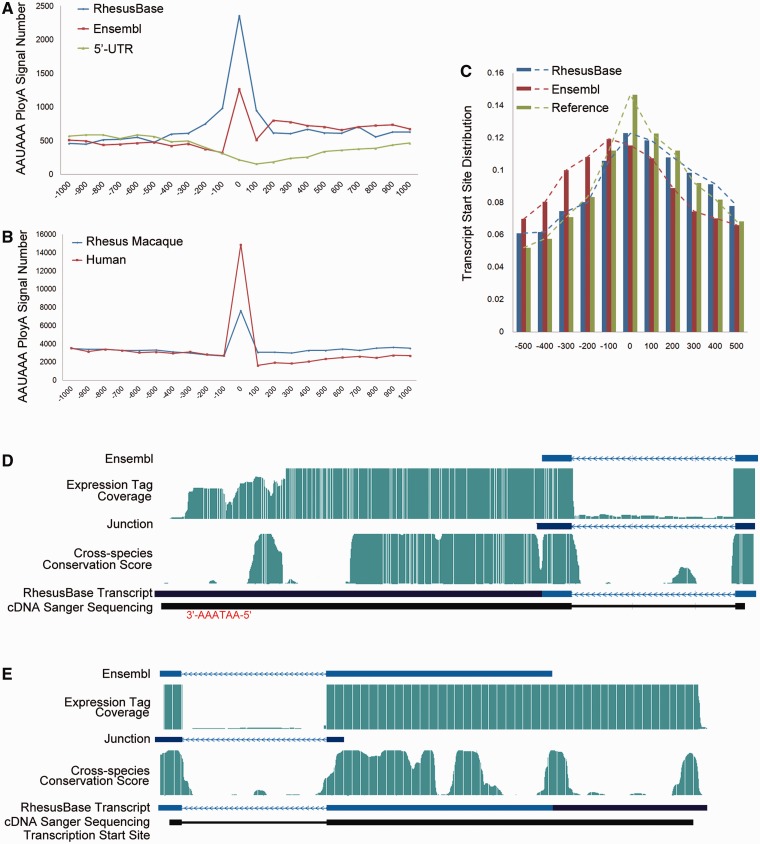
Evaluation of extended 5′- or 3′-UTRs. (A) Frequencies of AAUAAA hexamer near the end of the 3′-UTRs, on the basis of previous gene models (Ensembl) and the revised gene models (RhesusBase). Negative controls were generated using flanking regions near the start site of these transcripts (Negative Controls). (B) Frequencies of AAUAAA hexamer near the end of the 3′-UTRs, for transcript annotations in human and Ensembl annotations in rhesus macaque. (C) Distribution of the transcription start sites identified by ChIP-Seq study, on the basis of the previous and revised gene models. Reference: the end of the 5′-UTR supported by both previous and new models; (D and E) Gene structures of two experimentally verified transcripts revised by RhesusBase. Both the previous gene models (Ensembl) and the revised gene models (RhesusBase) are shown. RNA-Seq expression tag coverage, splicing junctions, cross-species conservation score, as well as sequenced cDNA fragments were aligned accordingly. AATAAA site (D) or transcription start site (E) identified by ChIP-Seq study are highlighted. The RNA-Seq expression tag coverage was set to the maximal score for sites with high tag coverage (>100).